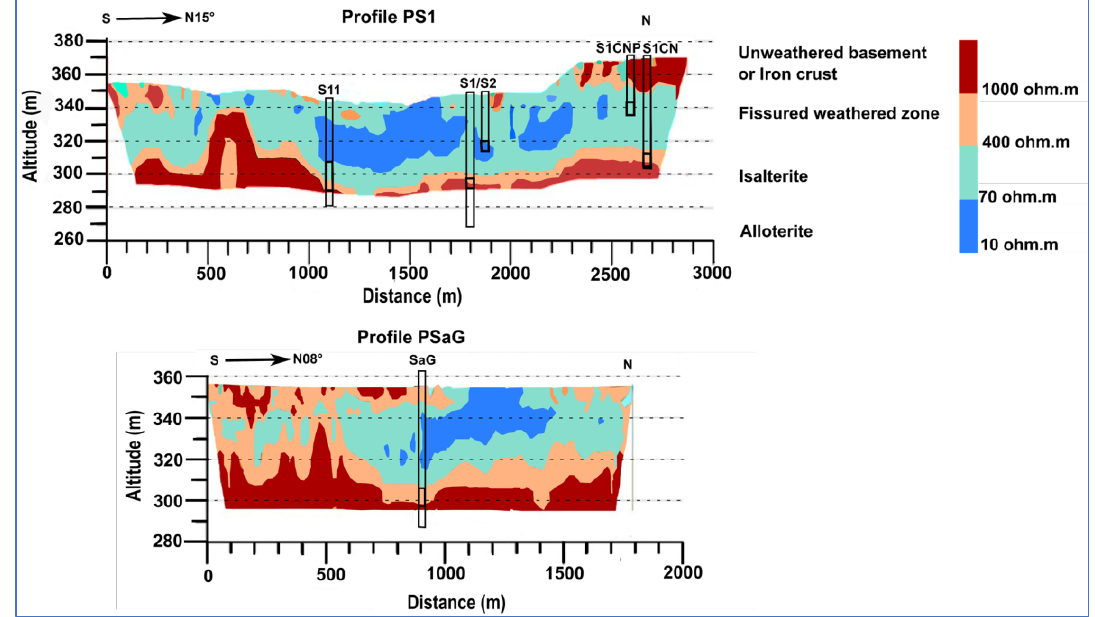
Figure 2. The 2D geological model and associated electrical resistivity values (adapted from [37,56]). S1CN, S1CNP, S1, S2, S11, and SaG are observation wells.